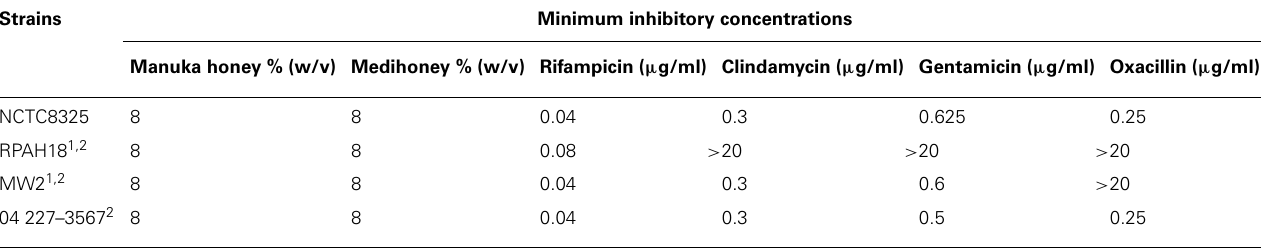
Table 1 | Minimum inhibitory concentrations (MICs) of antimicrobial agents against Staphylococcus aureus strains. Strains Minimum inhibitory concentrations